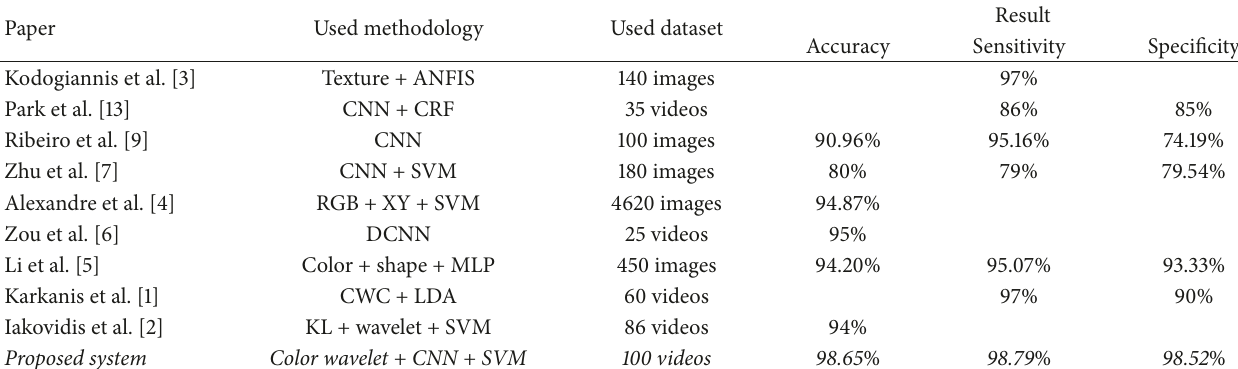
Table 1: Comparison among different polyp detection.